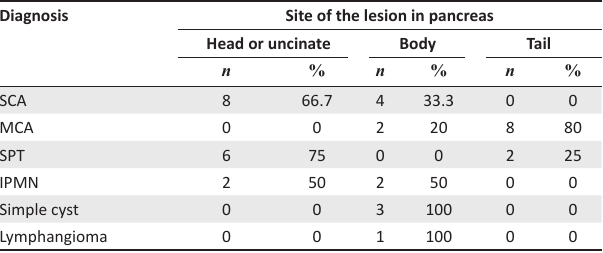
TABLE 2: Distribution of pancreatic cystic lesions as per the anatomic site. Diagnosis